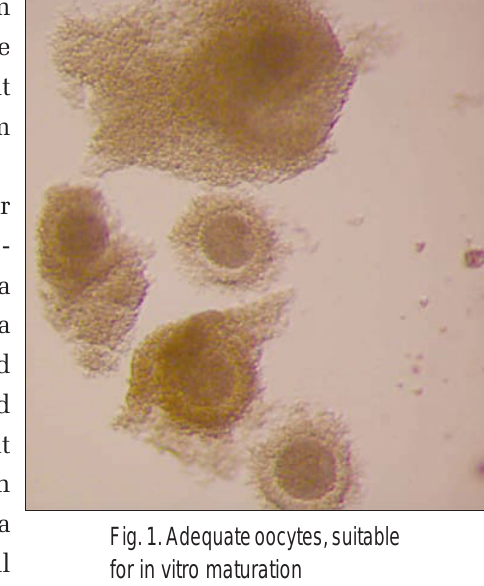
Fig. 1. Adequate oocytes, suitable for in vitro